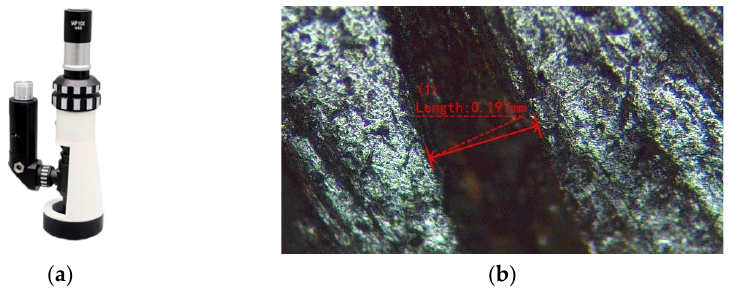
Figure 8. Measurement of the grinding marks by portable optical microscope: ( a ) portable optical microscope; ( b ) the picture of the grinding marks and the results after calibration.